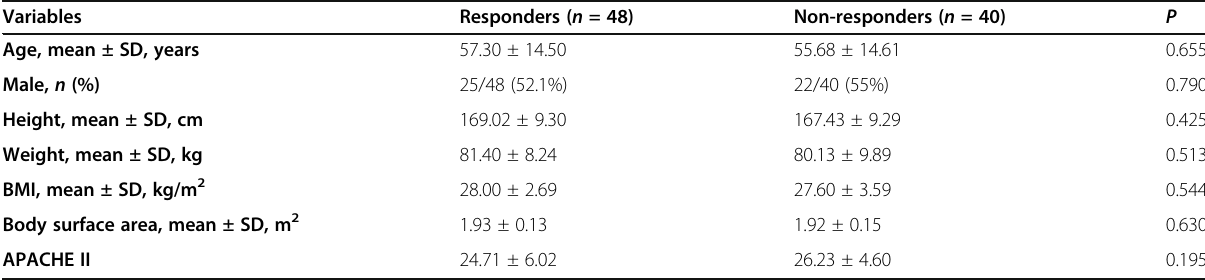
Table 1 Patient demographics Variables